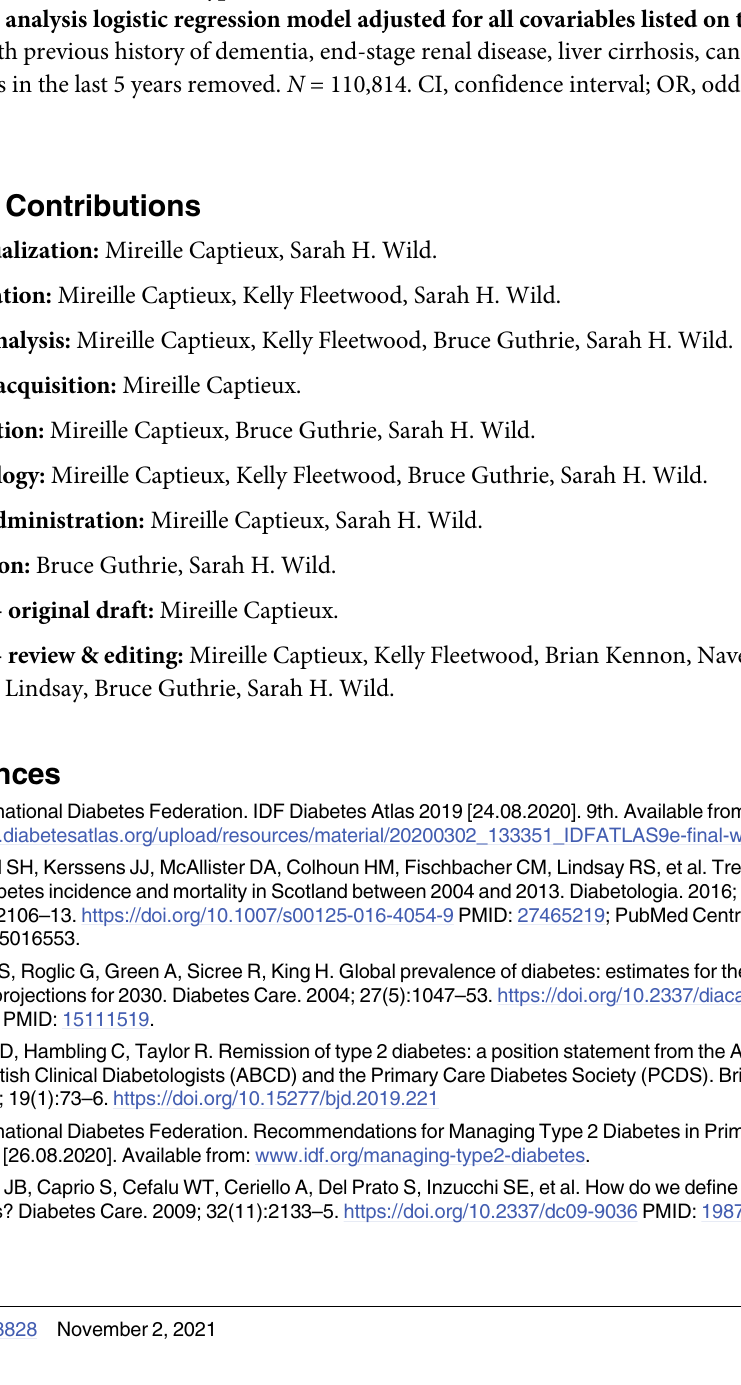
S3 Fig. Median weight change (kg) from diagnosis of type 2 diabetes to 2019 according to remission ( n = 7,710) and nonremission status ( n = 154,606). (DOCX) S4 Fig. ORs for remission of type 2 diabetes (95% CI) in Scotland 2019 derived from com- plete case analysis logistic regression model adjusted for all covariables listed on the plot. N = 117,048. CI, confidence interval; OR, odds ratio. (DOCX) S5 Fig. ORs for remission of type 2 diabetes (95% CI) in Scotland 2019 derived from com- plete case analysis logistic regression model adjusted for all covariables listed on the plot. People with previous history of dementia, end-stage renal disease, liver cirrhosis, cancer, or metastases in the last 5 years removed. N = 110,814. CI, confidence interval; OR, odds ratio.